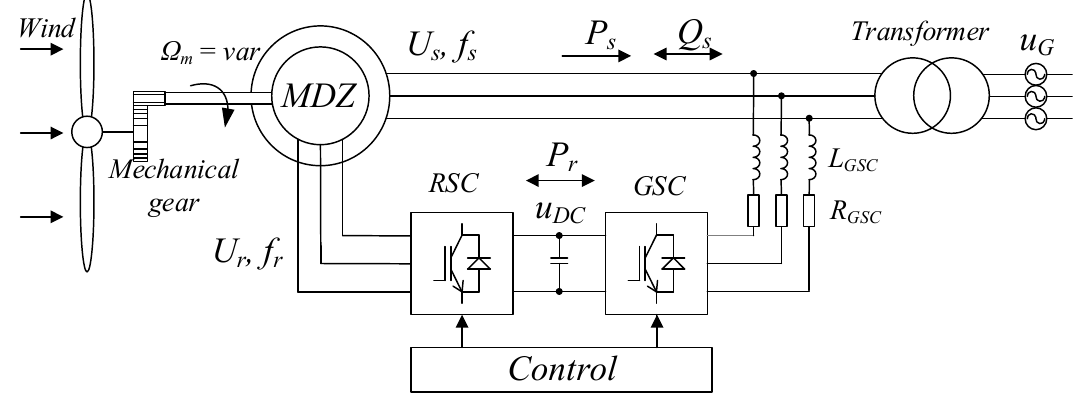
Figure 1. Simplified DFIG based wind power generator unit.